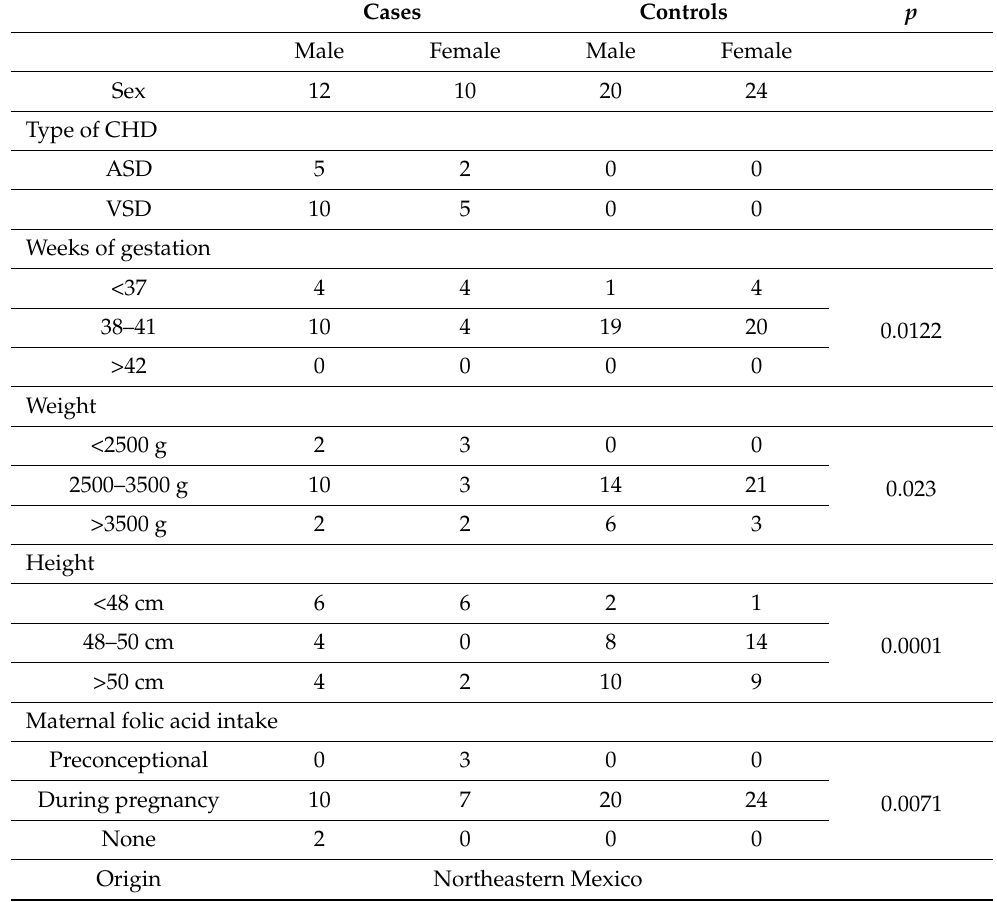
Table 1. Demographic characteristics of the cohort by case and control. Cases